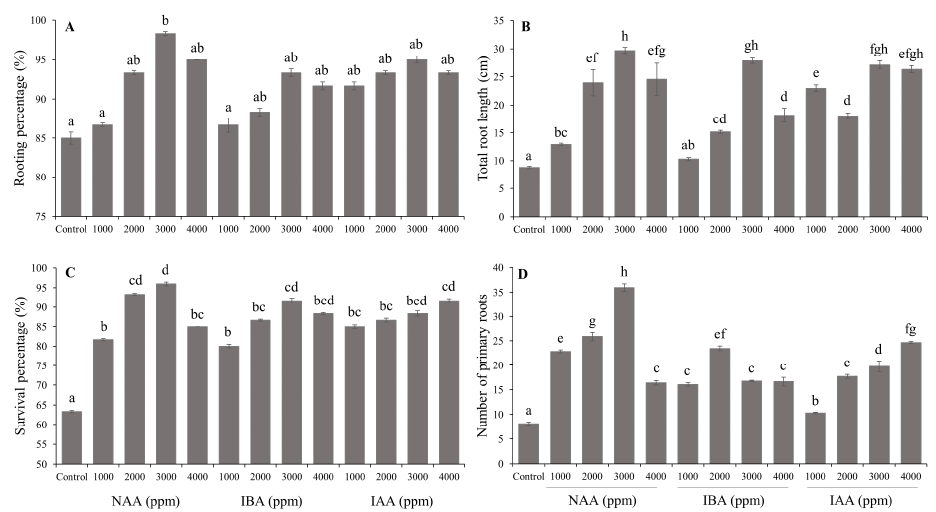
Figure 3. Effect of auxin treatment: ( A ) rooting percentage; ( B ) total root length; ( C ) number of primary roots; ( D ) survival percentage of Jasminum parkeri stem cuttings. Different letters indicate significant mean difference among treatments (DMRT, p ≤ 0.05).